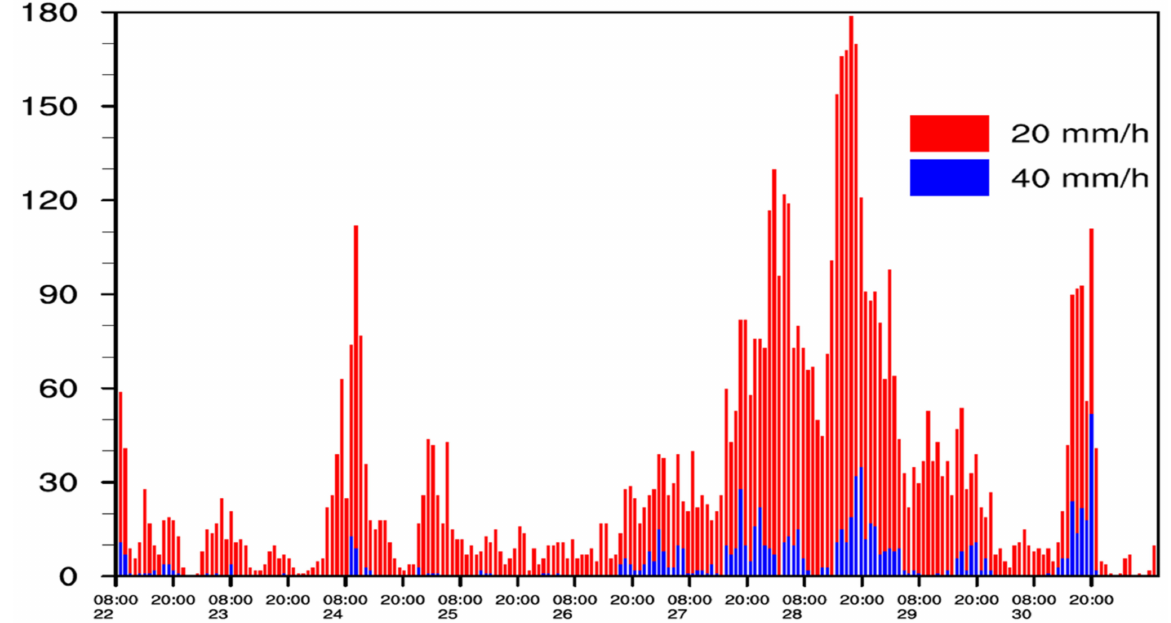
Figure 3. Number of observational stations with hourly rainfall exceeding 20 and 40 mm h − 1 during